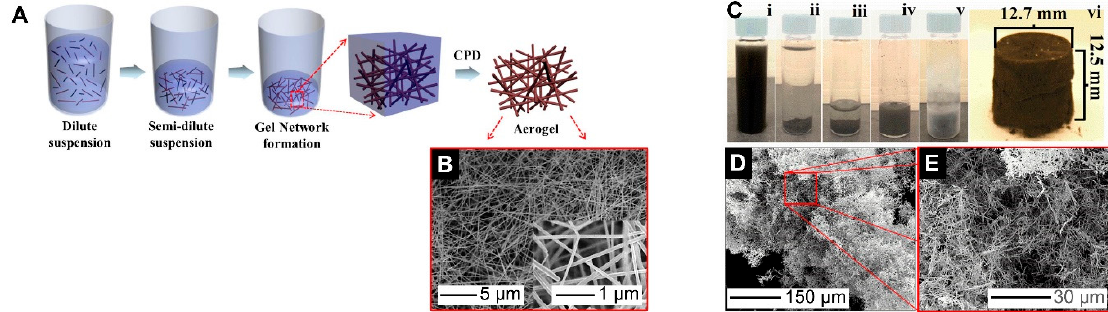
Figure 6. ( A ) Scheme of the fabrication of nanowire aerogels, based on gelation of nanowire suspensions, followed by critical point drying (CPD), including SEM images of a Ag nanowire aerogel ( B ). ( A , B ) are reprinted (adapted) with permission from [75]. Copyright (2012) Springer Nature Limited. ( C ) Preparation of 3D palladium nanowire networks via freeze-casting and freeze-drying, starting from a nanowire suspension (i), which after settling (ii) is adjusted to the desired volume (iii), redispersed (iv), and frozen in liquid nitrogen (v), yielding a monolithic sponge after freeze-drying (vi). ( D , E ) SEM images of a freeze-dryed Pd nanowire network. ( C – E ) are reprinted (adapted) with permission from [77]. Copyright (2017) American Chemical Society.